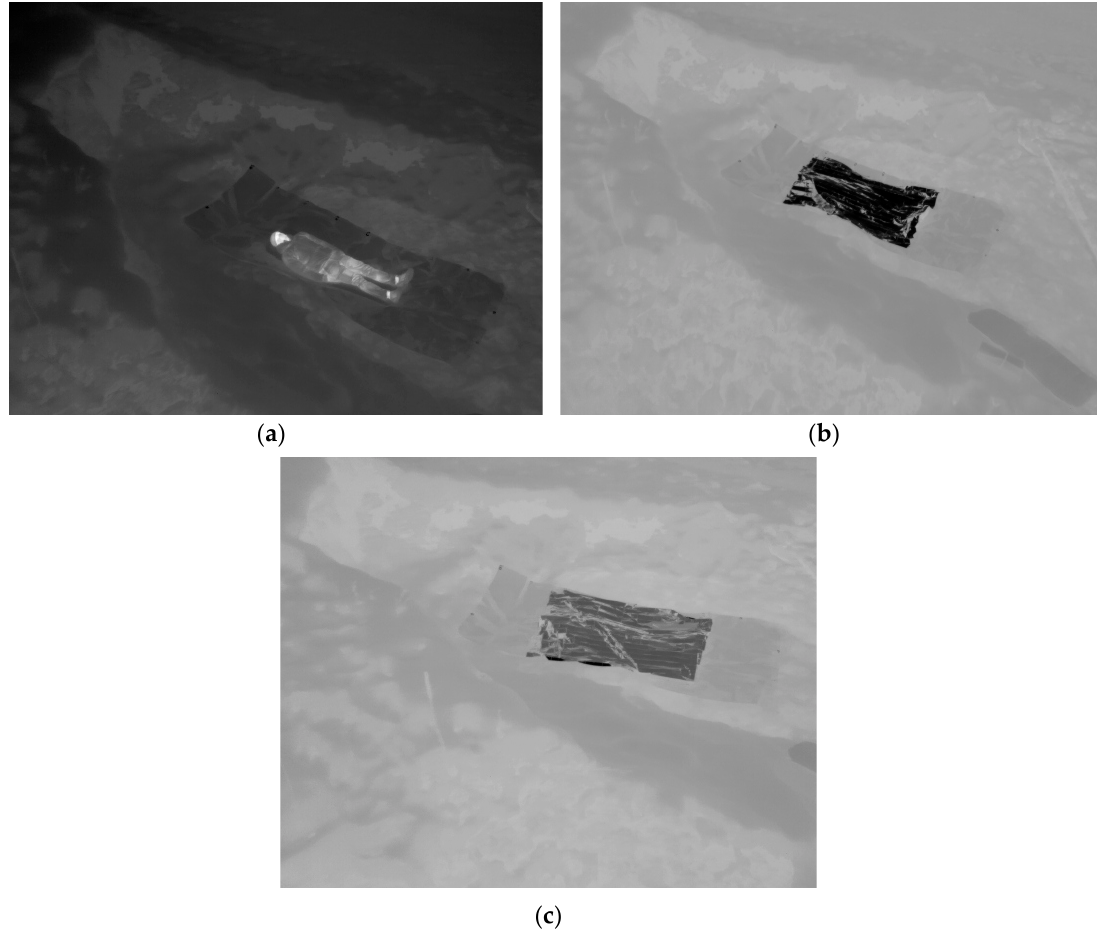
Figure 2. Thermal images in a snow-covered backcountry environment. ( a ) Model in supine position on an insulating sheet. ( b ) Model in supine position on an insulating sheet covered with a single-layer rescue blanket, silver side up. ( c ) Model in supine position on an insulating sheet covered with a single-layer rescue blanket, gold side up (air temperature: − 6.2 °C; snow temperature: − 7.6 or − 6.3 °C when considering the emissivity coefficient ε = 0.83 for snow).